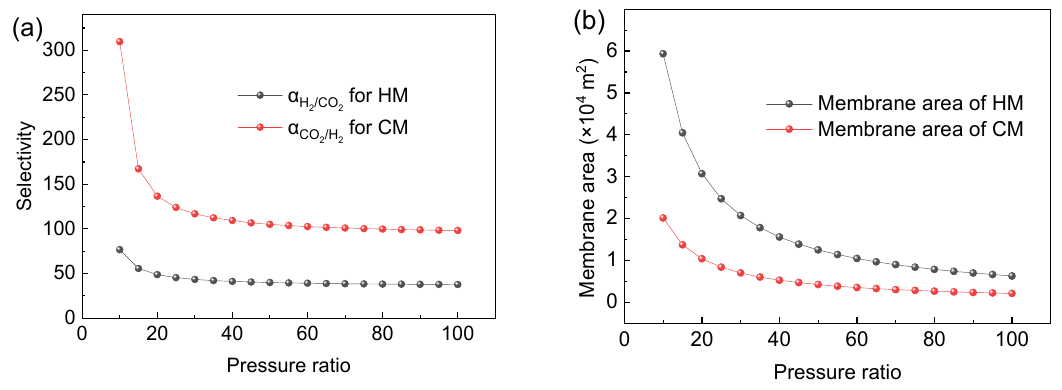
Figure 4. The selectivity ( a ) and membrane area ( b ) required of HM and CM under different compression ratios with CO 2 purity and recovery set to 96% and 90% (assuming H 2 permeance of CO 2 ‐ selective membrane and CO 2 permeance of H 2 ‐ selective membrane are 20 GPU).